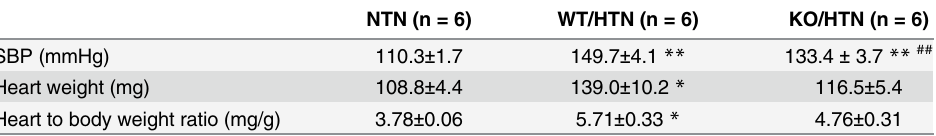
Table 1. Hypertension in COX-1 -/- 2K1C